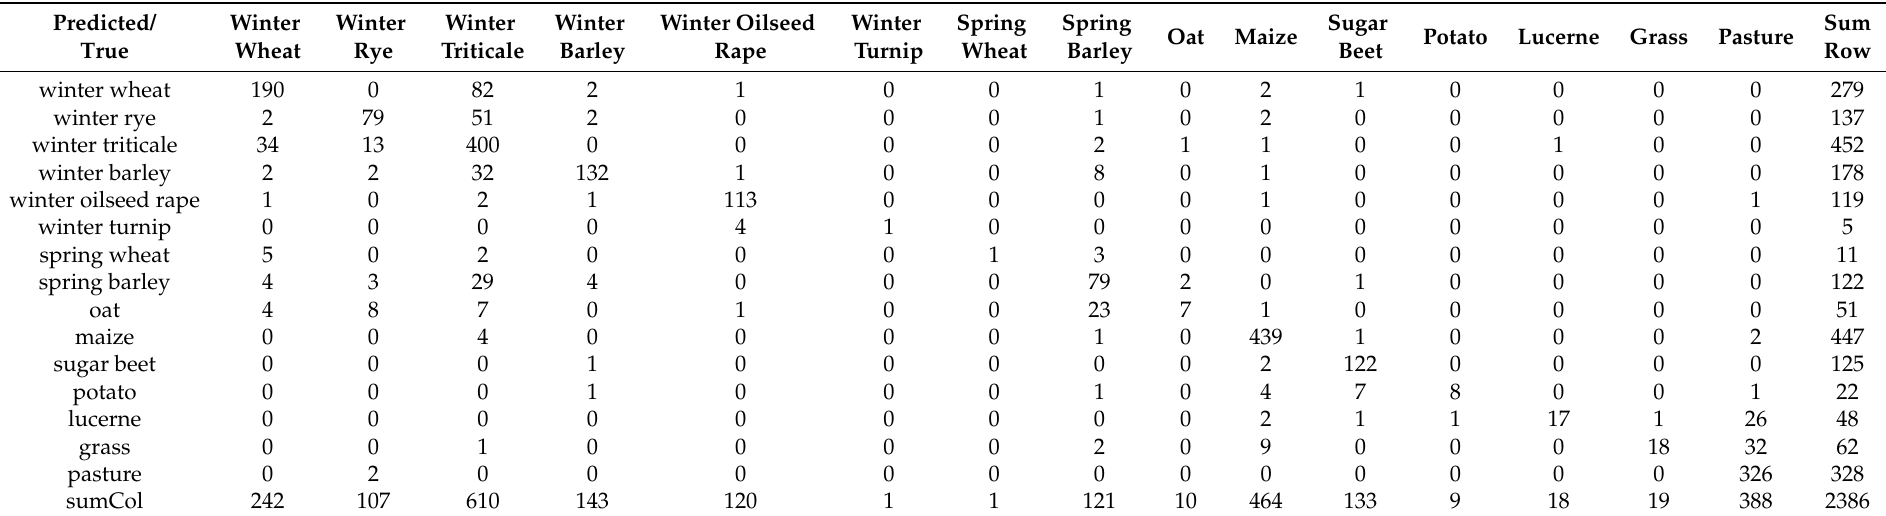
Table A1. Full confusion matrix calculated for RF classification of Combination4VV based on entire training set (1,412,092 pixels) using the object-oriented accuracy analysis (2386